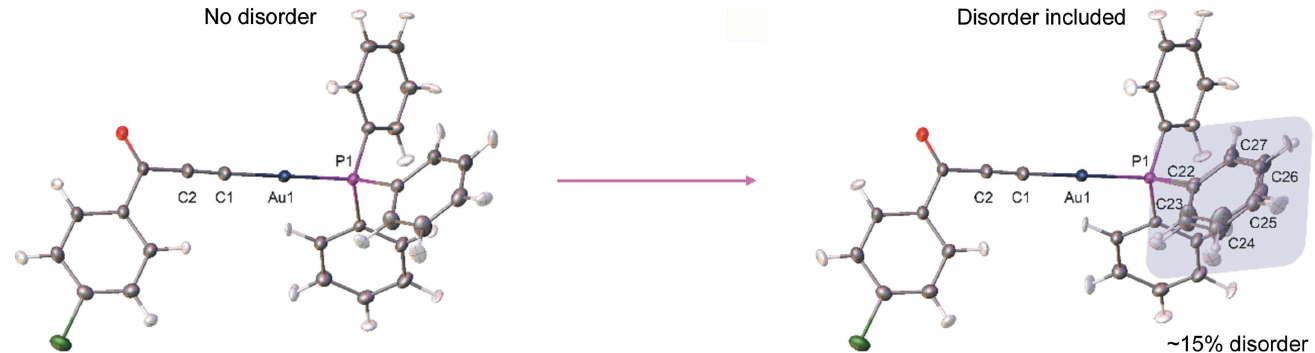
Figure 3 Structure of the investigated compound after HAR refinement (rks_rel_anis). The phenyl ring shown above is affected by 15% disorder after